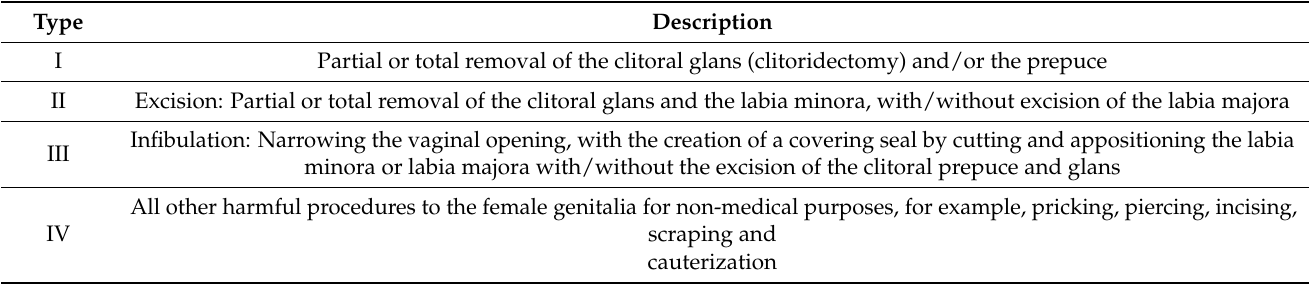
Table 1. World Health Organization classification of female genital